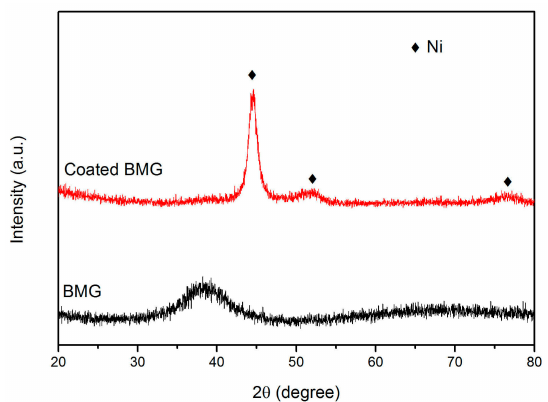
Figure 4. The X-ray diffractometer (XRD) spectra of the Ti-based BMG rod before and after electroless Ni plating.